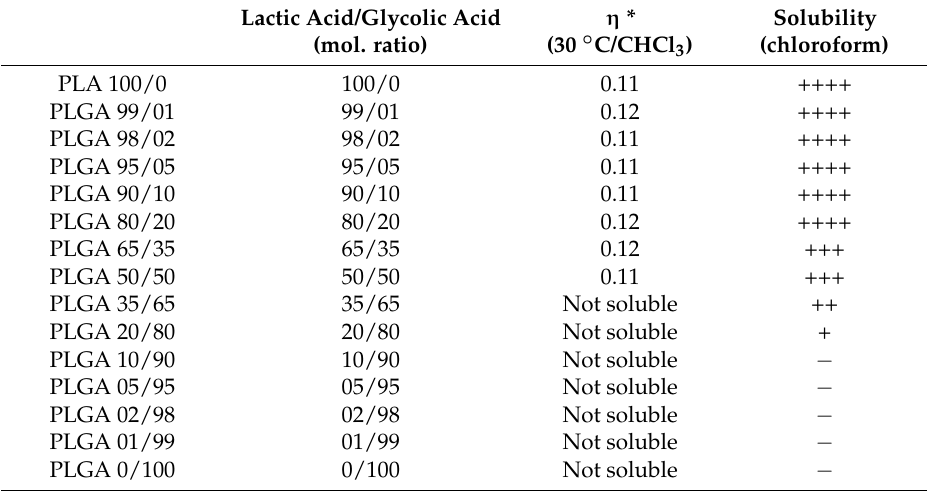
Table 1. Synthesis of polylactic- co -glycolic acid oligomers with different chemical compositions. Lactic Acid/Glycolic Acid (mol.